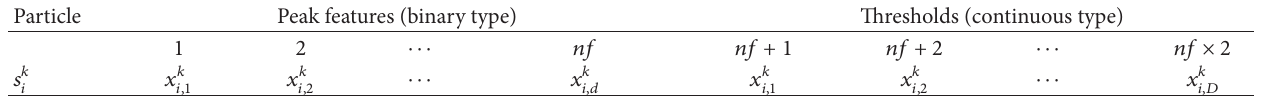
Table 4: Representation of particle